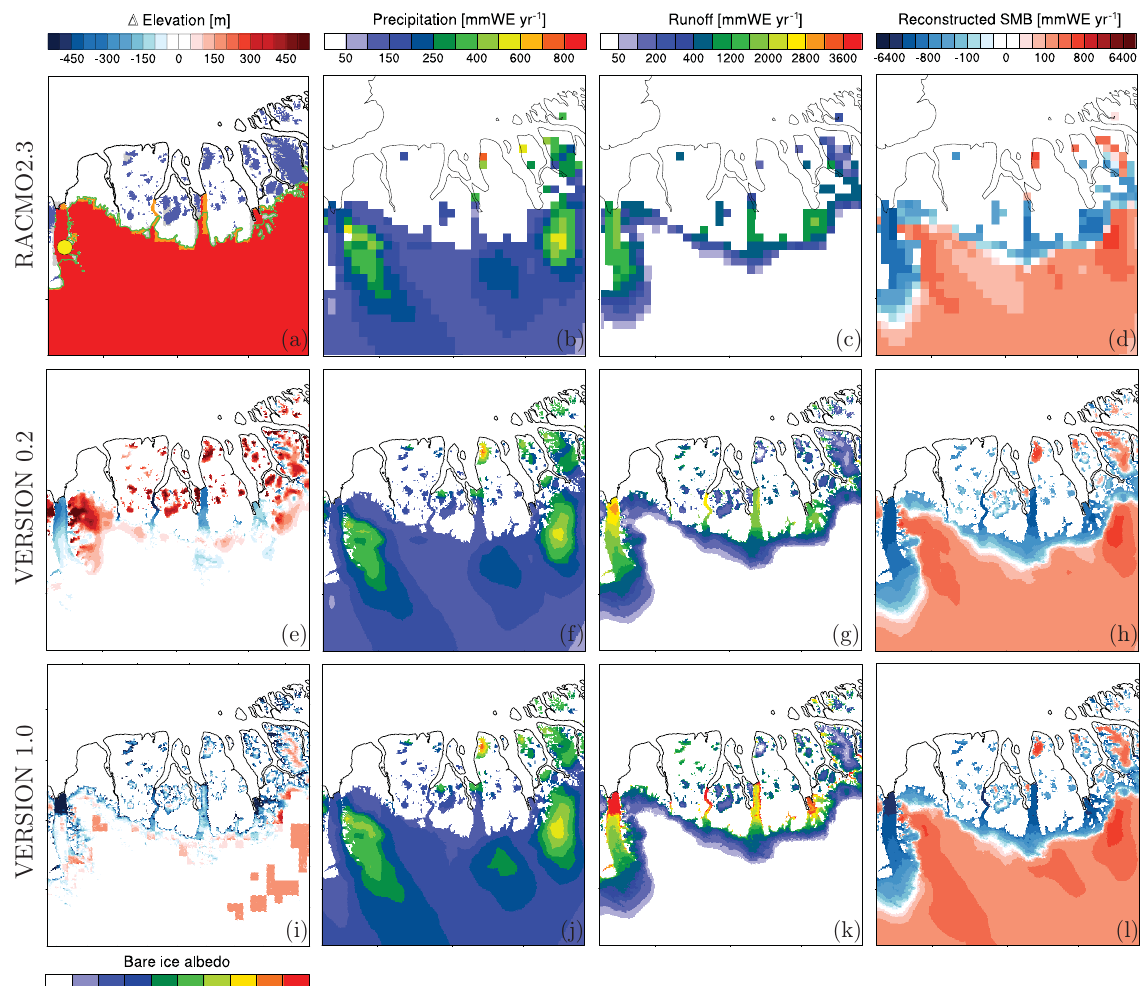
Figure 13. North: same as Fig. 10 but for north Greenland (blue box 4 in Fig. 1). The green line in (a) shows the grounded ice mask at 1km. The yellow dot in (a) locates the Petermann glacier site settled on a floating ice